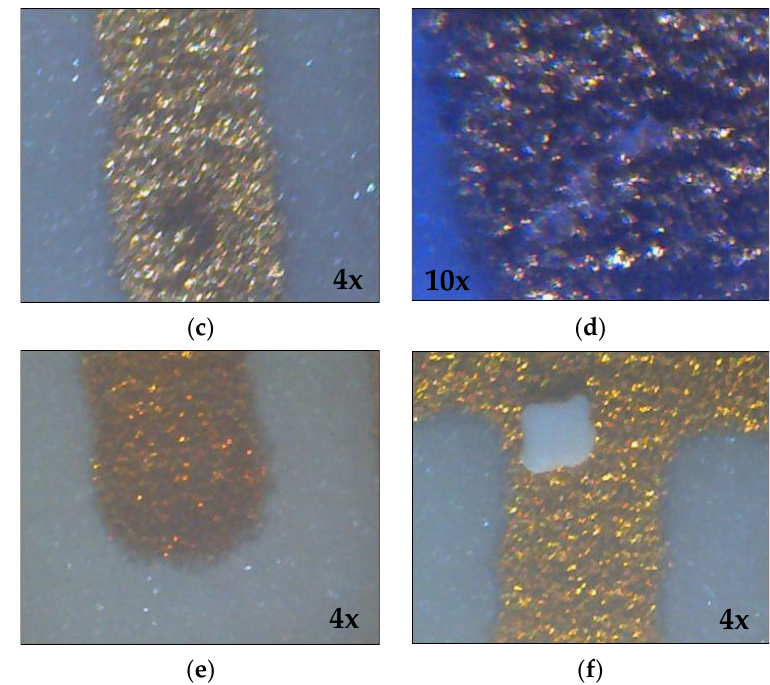
Figure 7. Optical microscopy images of the IDE sensors showing the damage caused by the increas- ingly higher values of the voltage applied during the impedance measurements. ( a ) Uncoated IDE before applying voltage, ( b ) IDE coated with (PEI/PSS) 5 film before applying voltage, ( c ) uncoated IDE after applying voltage while immersed in MW, ( d ) IDE coated with (PEI/PSS) 5 film after apply- ing voltage while immersed in MW, ( e ) uncoated IDE after applying voltage while immersed in TW, ( f ) IDE coated with (PEI/PSS) 5 film after applying voltage while immersed in TW.